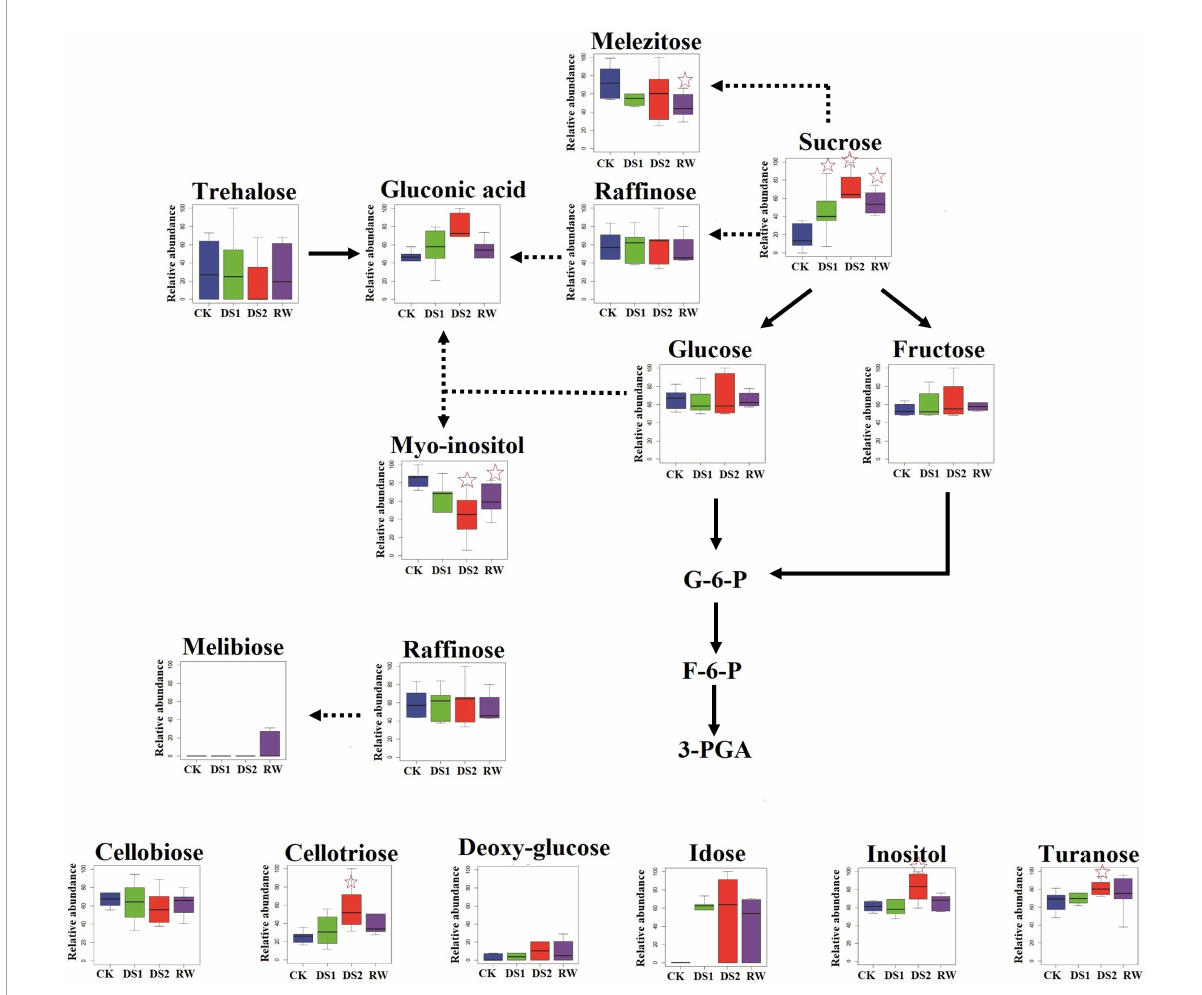
FIGURE7 Differences in sugar and sugar alcohol metabolisms among tea plants of different drought stresses and re-watering. The x -axis represented the treatments. The y -axis box plots indicated the scaled intensity median (—) values: top/bottom ranges of boxes indicated upper/lower quartiles, respectively; top/bottom whiskers indicated the maximum/minimum distribution of the data. The five-pointed star indicated that the metabolite was significantly differential in the sample compared with